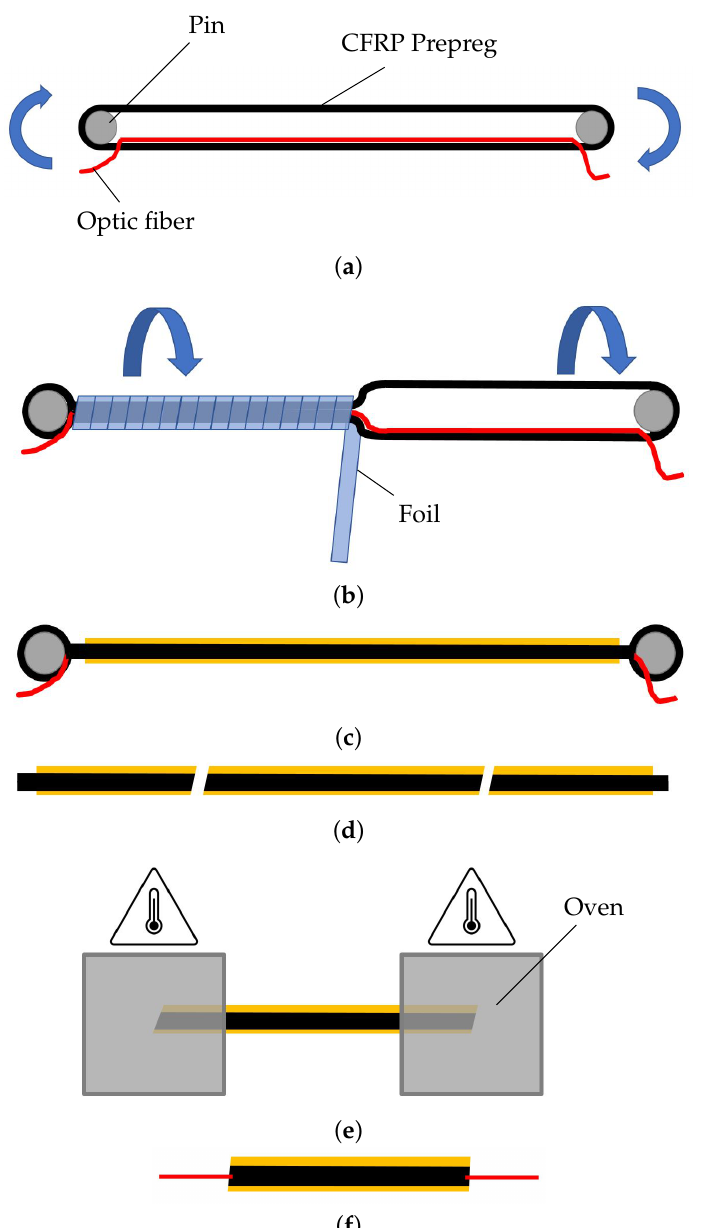
Figure 11. Procedure for manufacturing a CFRP tendon with an integrated optical fiber. ( a ) CFRP prepreg is wrapped around two pins, an optical fiber is placed in the middle of the loop; ( b ) the CFRP loop is rotated around its axis while being wrapped in foil; ( c ) the foil is removed after curing and the sand layer is applied; ( d ) the CFRP tendon is sawed into shorter pieces; ( e ) the matrix is decomposed in an oven by heating to 400 ◦ ; ( f ) the exposed carbon fibers can be removed, and the optical fiber can be separated. The connection for the measuring device can then be spliced onto the end of the optical